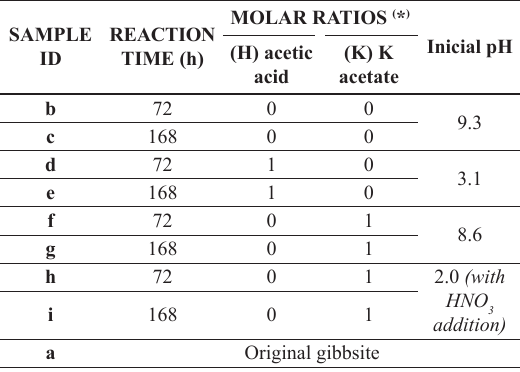
Table 1 – Identification of the samples and their respective hydrothermal reaction